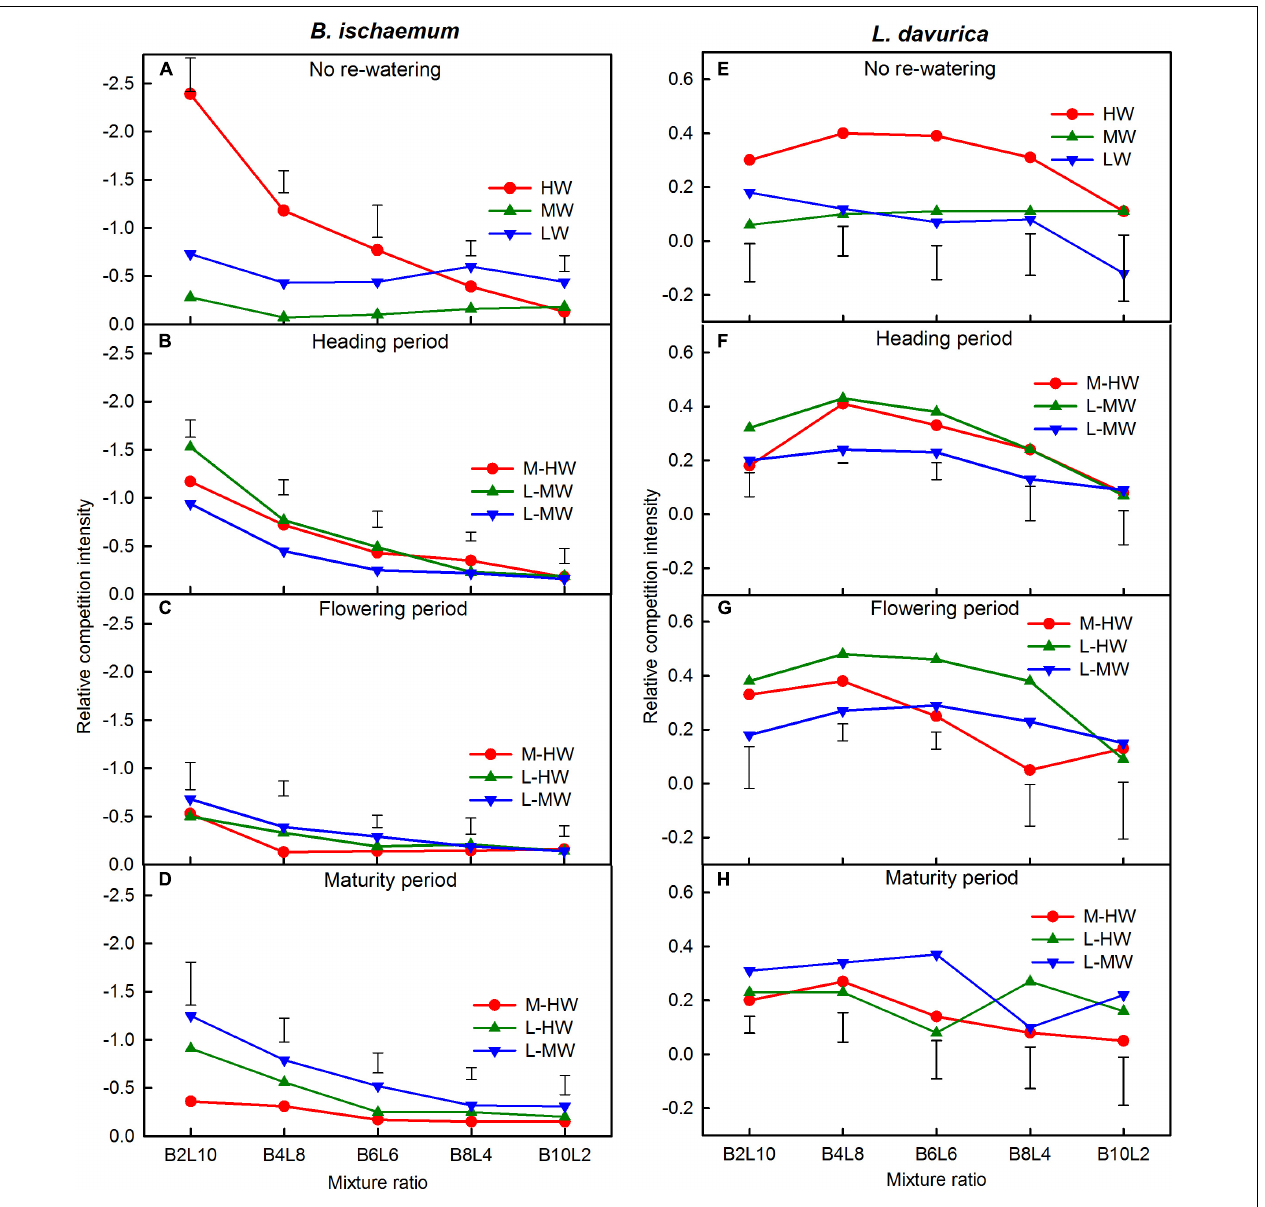
FIGURE 5 | (A–H) The relative competition intensity (RCI) for the total biomass of B. ischaemum (B) and L. davurica (L) in the mixtures under the soil watering treatments during different growth periods. B i L j ( i, j = 0, 2, 4, 6, 8, 10, 12; i + j = 12) in abscissa indicates the plant numbers of B. ischaemum to L. davurica in their mixtures; Vertical bars represent LSD 0.05 values. Refer to Figure 1 for the codes of the water